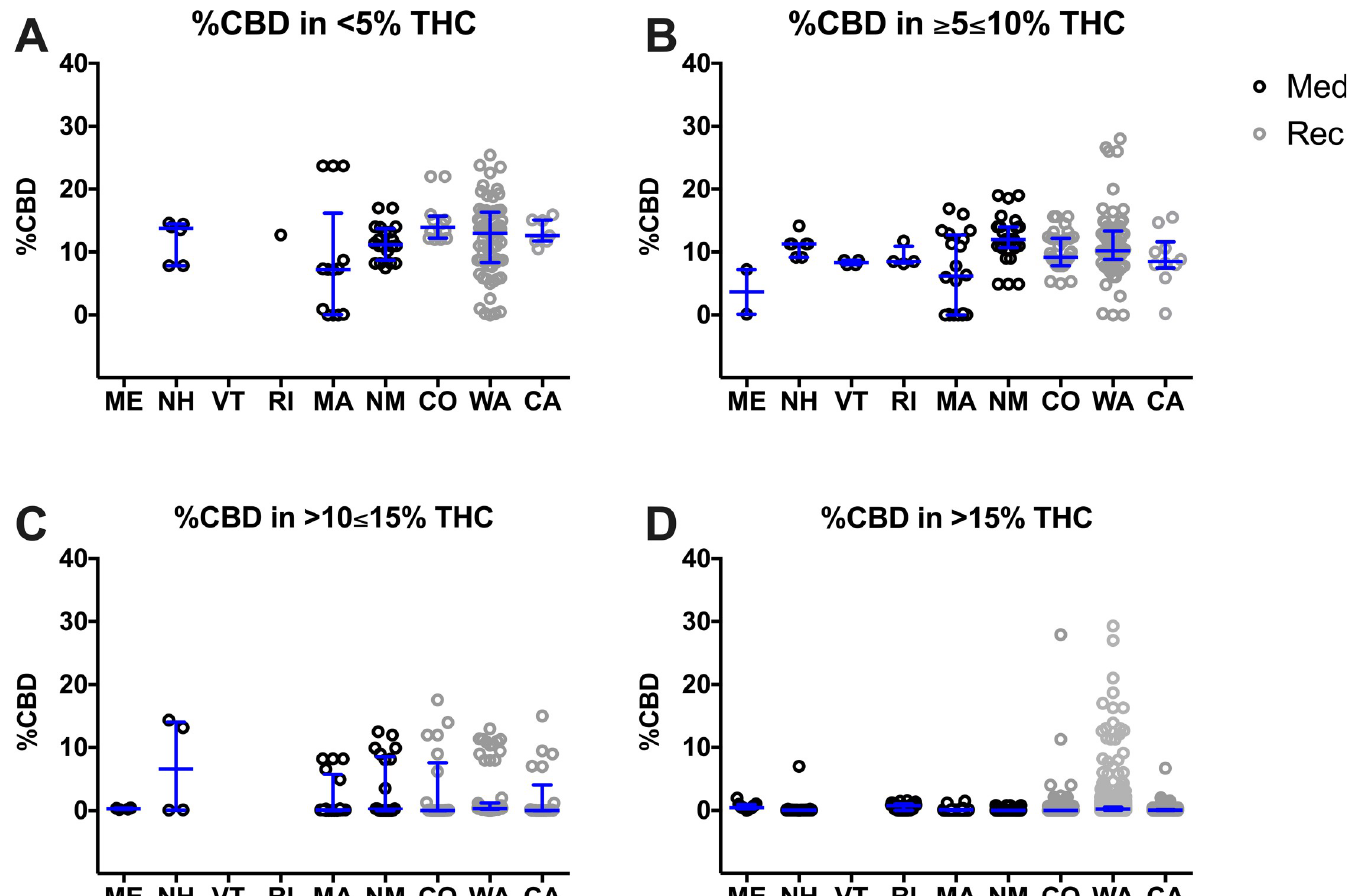
Fig 5. Percent CBD at different strength product categories based on THC content per state. Products are presented in the following categories: < 5% THC (A), � 5 � 10% THC (B), > 10 � 15% THC (C), and > 15% THC (D). Every herb cannabis product in the surveyed states is plotted as an open circle. States with medicinal only (Med; black circles) and recreational and medicinal (Rec; grey circles) programs were compared. Data are presented as median with interquartile range. Statistic significant changes (P < 0.05) were observed between the following states: MA vs. WA and MA vs. NM in � 5 � 10%; MA vs WA, CO vs. WA, NM vs. WA in > 15%. One- way ANOVA and Tukey’s multiple comparison test. Descriptive statistics could be found in S8